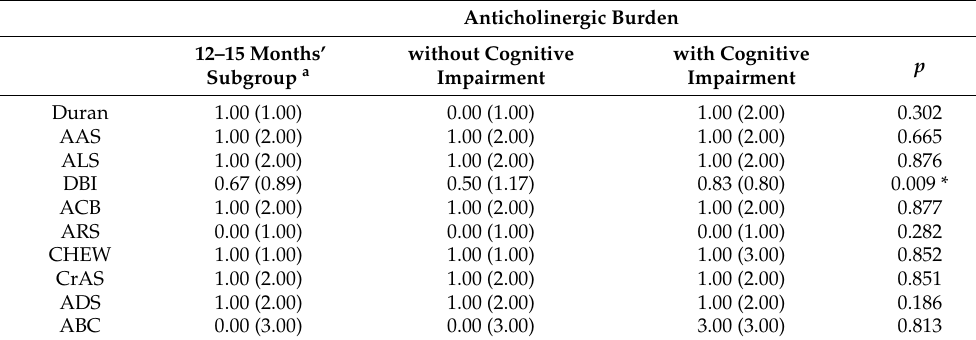
Table A6. Anticholinergic burden by all the scales in subgroups of patients evaluated on 12–15 months, with and without cognitive impairment.